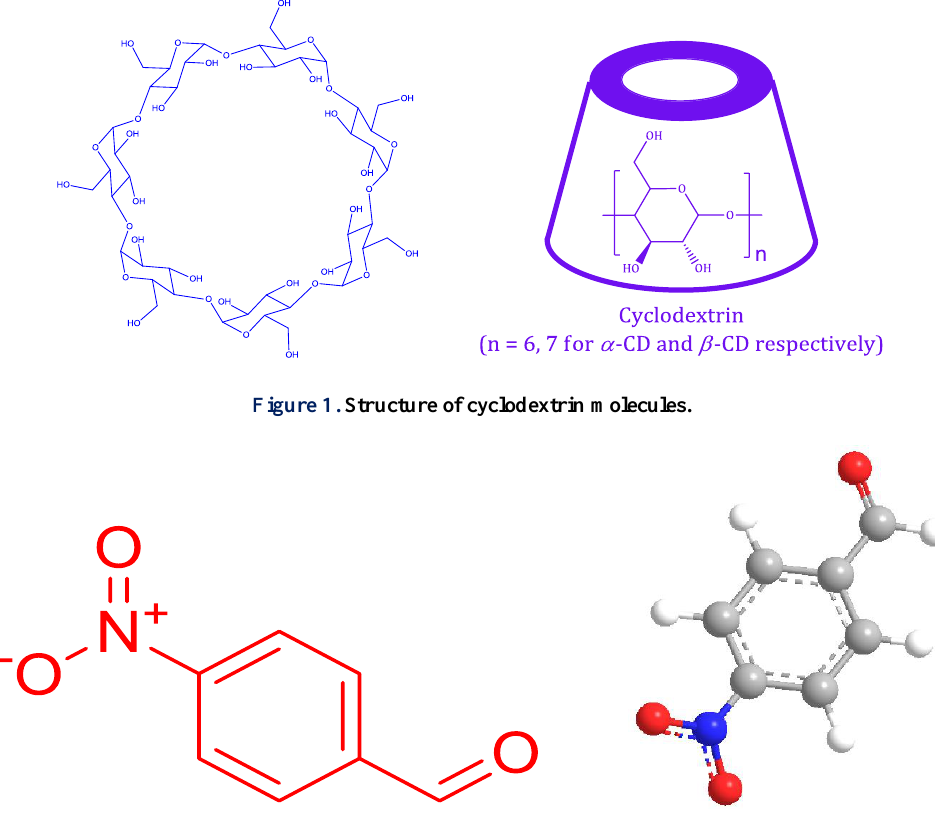
Figure 2. Two dimensional and three dimensional structure of